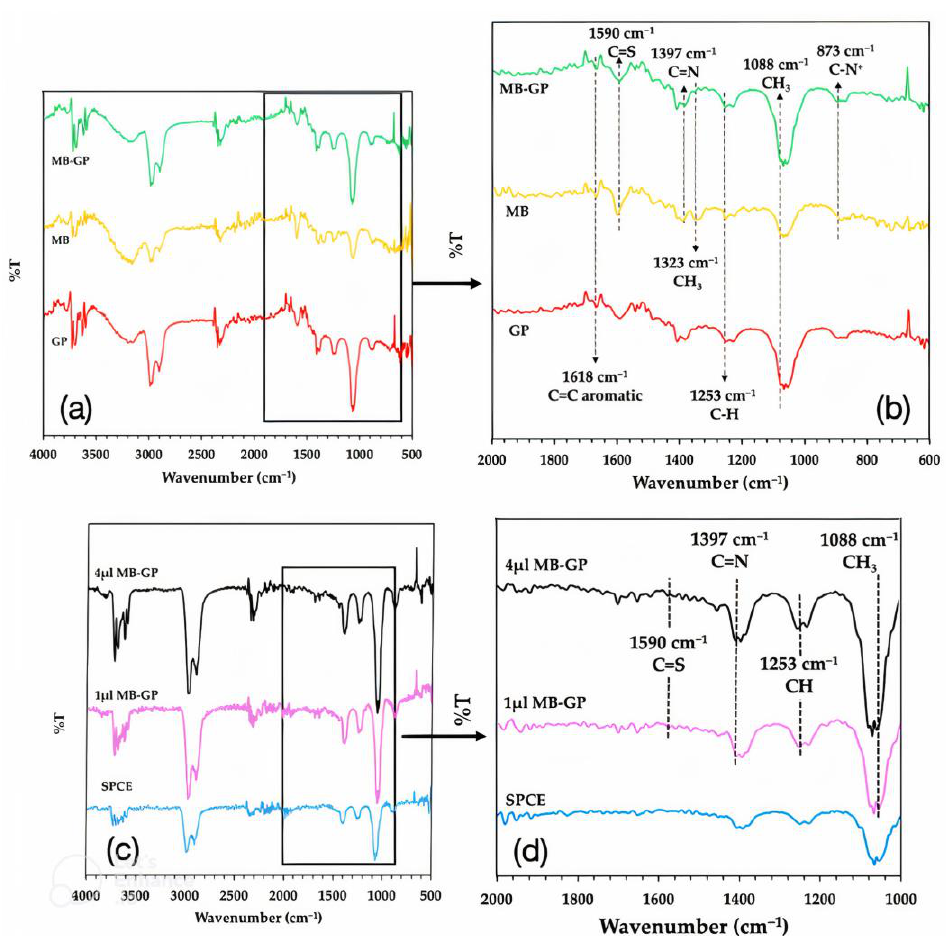
Figure 5. FT-IR spectra of GP (bottom), MB (middle), and MB/GP (top) in DI water ( a ) at Figure 5. FT - IR spectra of GP ( bottom ) , MB ( middle ) , and MB / GP ( top ) in DI water ( a ) at 500–5000 500–5000 cm − 1 and ( b ) at 600–2000 cm − 1 . FT-IR spectra of SPCE (bottom), 1 µ L of Mb/GP (middle), cm − 1 and ( b ) at 600–2000 cm − 1 . FT - IR spectra of SPCE ( bottom ) , 1 μL of Mb / GP ( middle ) , and 4 μL and 4 µ L of Mb/GP (top) modified on SPCE ( c ) at 500–4000 cm − 1 and ( d ) at 1000–2000 cm − 1 of Mb / GP ( top ) modified on SPCE ( c ) at 500–4000 cm − 1 and ( d ) at 1000–2000 cm − 1 .